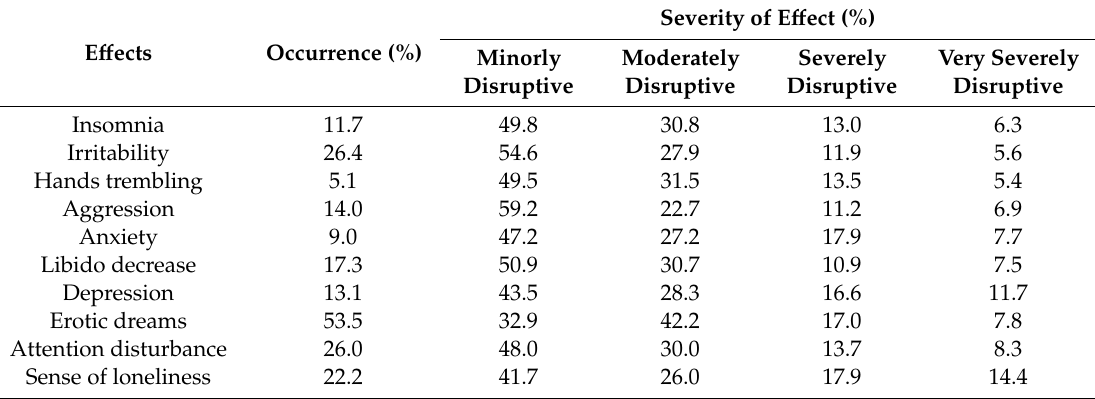
Table 2. The self-perceived e ff ects reported by surveyed individuals during attempts to cease pornography use ( n =